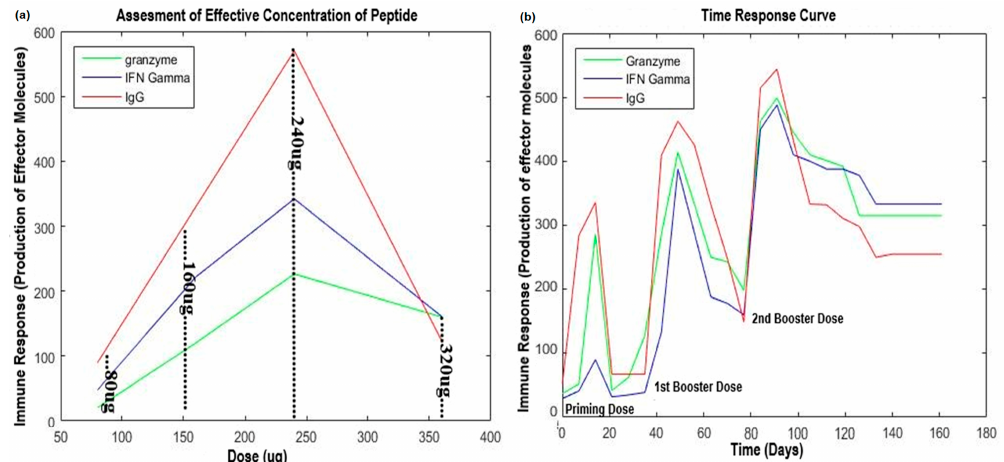
Figure 2. Assessment of effective concentration of potential epitopes ( a ) and time response curve ( b ).